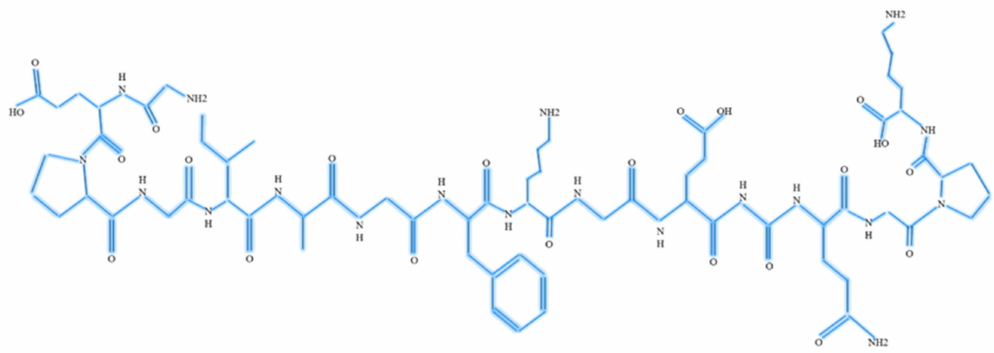
Figure 1. Structure of